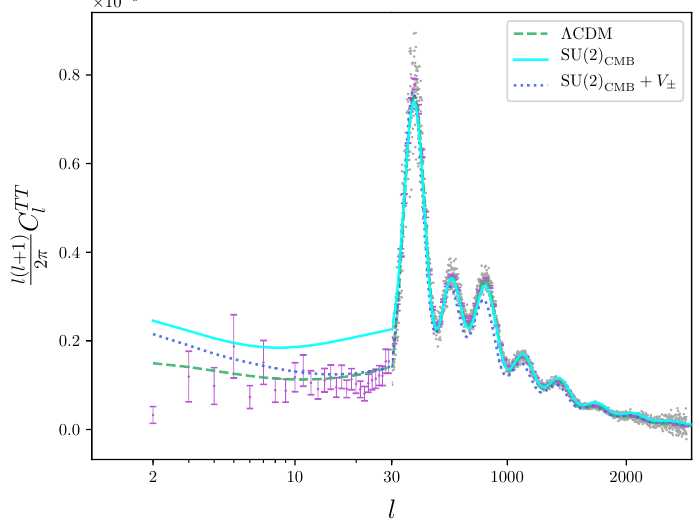
Figure 2. Normalised power spectra of TT correlator for best-fit parameter values quoted in Table1: Dashed, dotted, and solid lines represent Λ CDM, SU(2) + V (not considered in in the present work), CMB ± and SU(2) , respectively. For l 29 the 2015 Planck data points are unbinned and carry error bars, CMB ≤ for l 30 grey points represent unbinned spectral power. Figure adopted from ≥